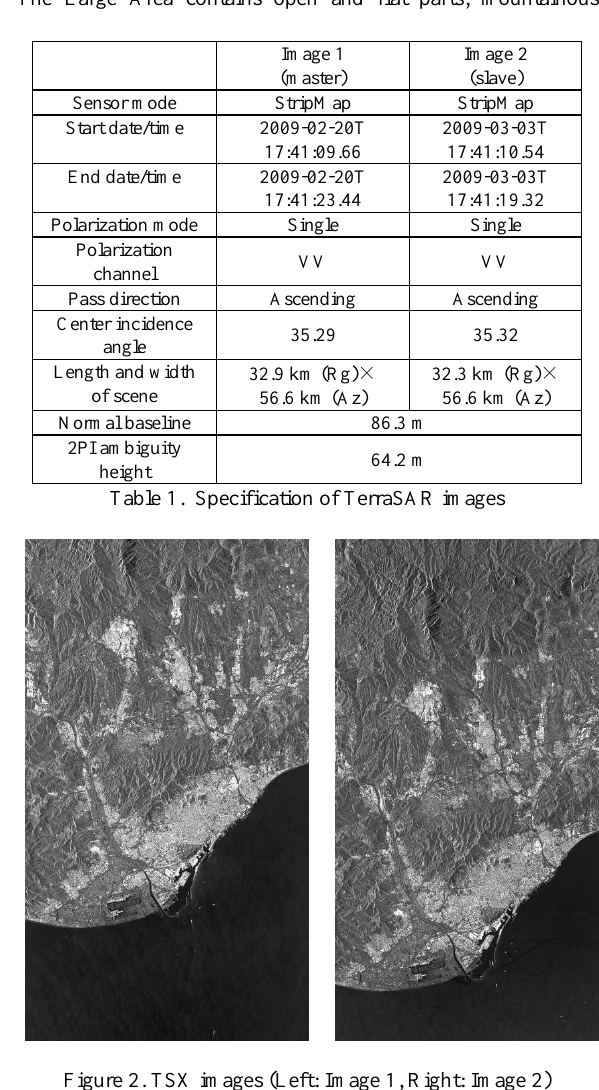
Figure 2. TSX images (Left: Image 1, Right: Image